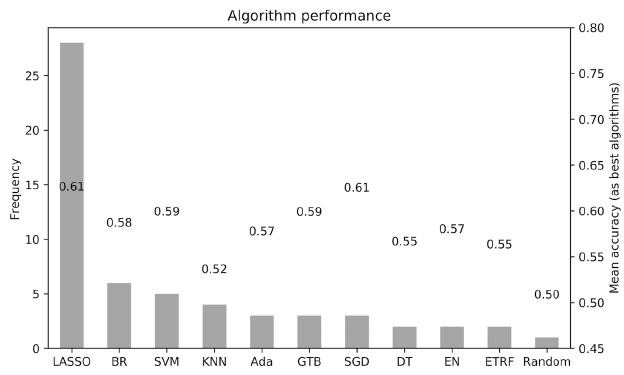
Figure 15: Summary of algorithm performance (predicting